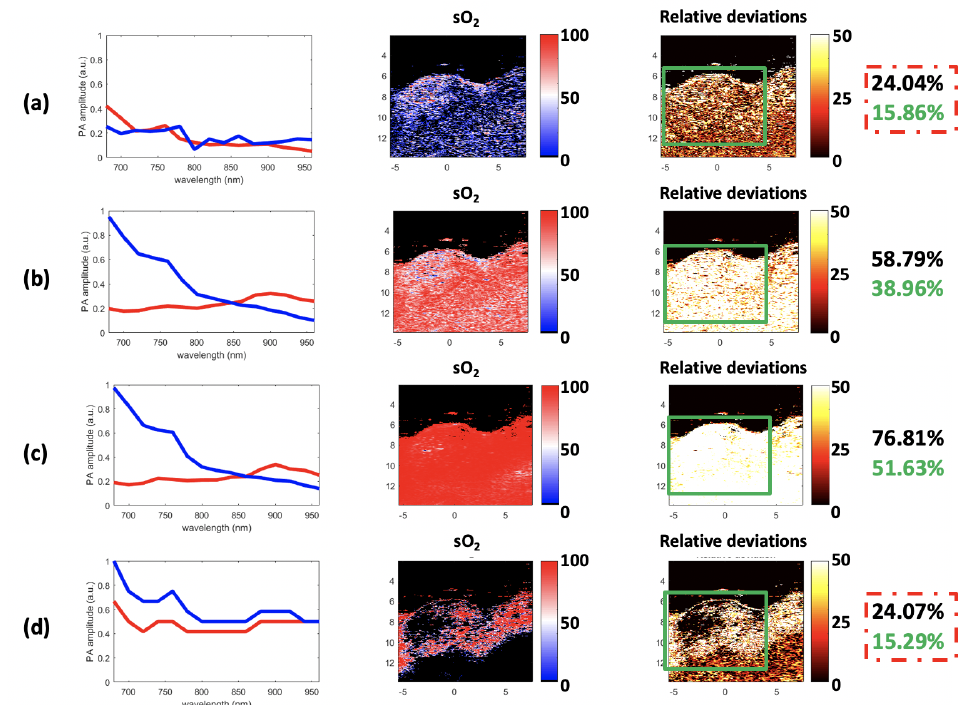
Figure 13. Results for ( a ) GLUP, ( b ) VCA, ( c ) N-FINDR, and ( d ) SSM-S. The extracted endmembers are shown (left). The mean values of the endmembers are: 0.17, 0.39, 0.41, and 0.61 for Hb (in blue) and 0.16, 0.24, 0.24, and 0.48 for HbO 2 (in red), respectively for GLUP, VCA, N-FINDR, and SSM-S. The sO 2 maps estimated using the FCLS with the extracted endmembers and Equation (16) are highlighted (center). The relative deviation maps between these sO 2 maps and the Vevo LAZR map in Figure 12 are presented (right). The mean relative deviations for the whole image (black) and limited to the tumor (green) are given on the far right. The minimal relative deviations are circled in red. The image axes are in